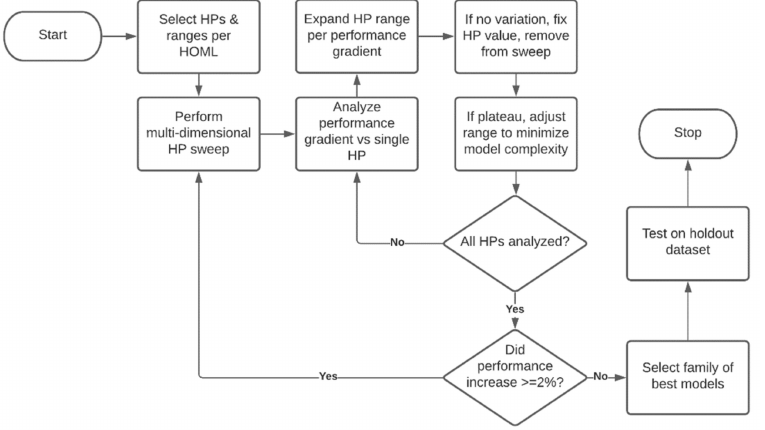
Figure 3. Flowchart for iterative multidimensional hyperparameter search. HP: hyperparameter; HOML: hands-on machine learning with TensorFlow [28].